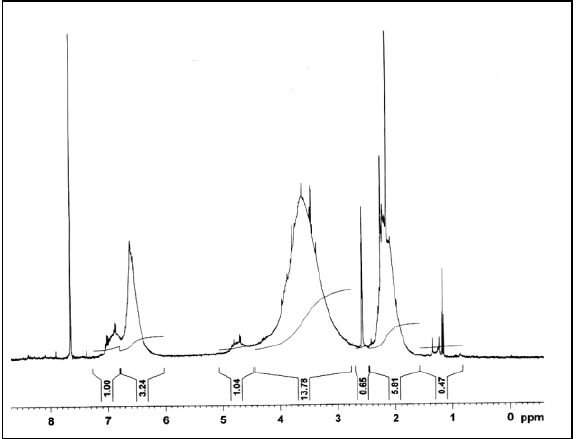
Figure 3: NMR spectra of m-CHF-I resin.